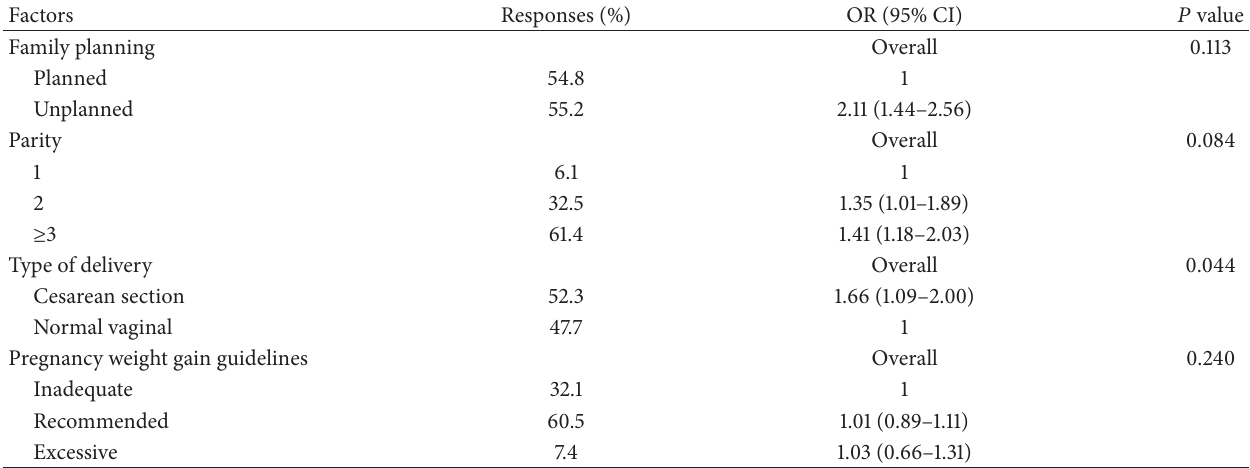
Table 3: Univariate odd ratios (ORs) for materiality risk factors of postpartum depression.